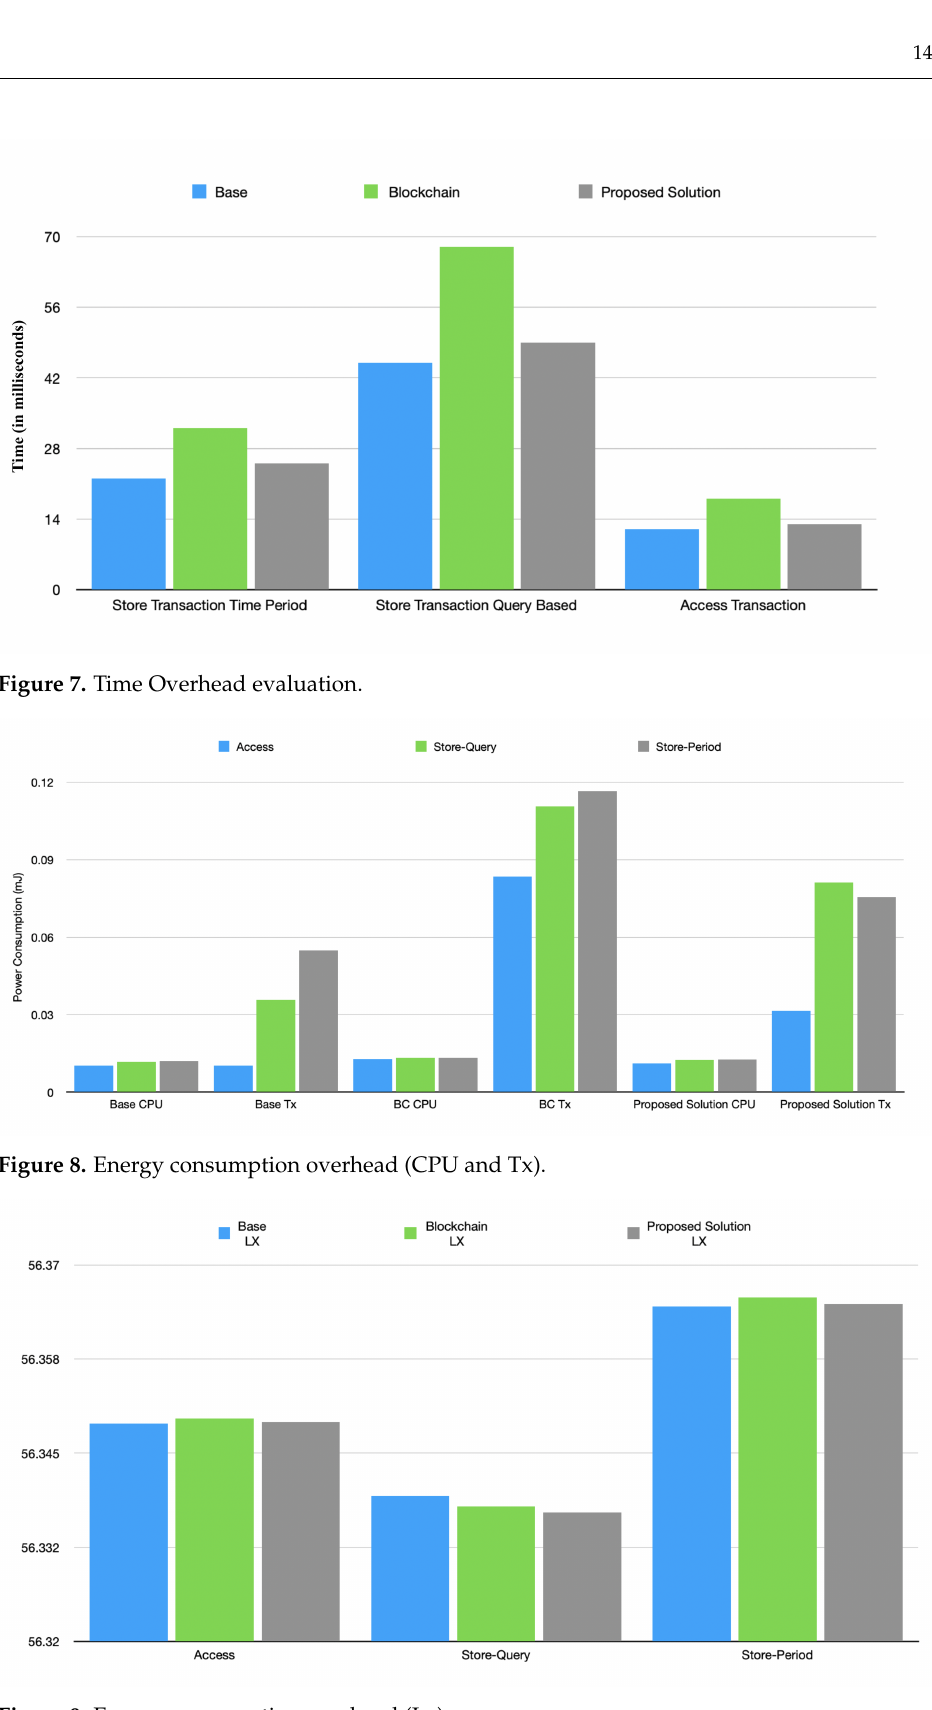
Figure 9. Energy consumption overhead